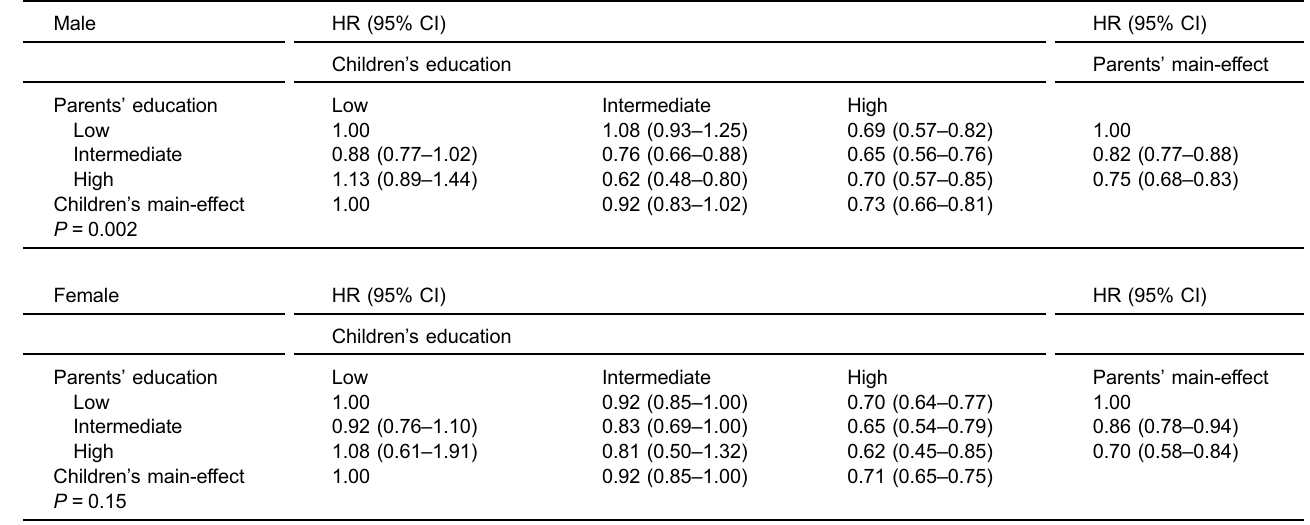
Table 4. Interaction e ff ects between parent ’ s education and children ’ s education for predicting hazard